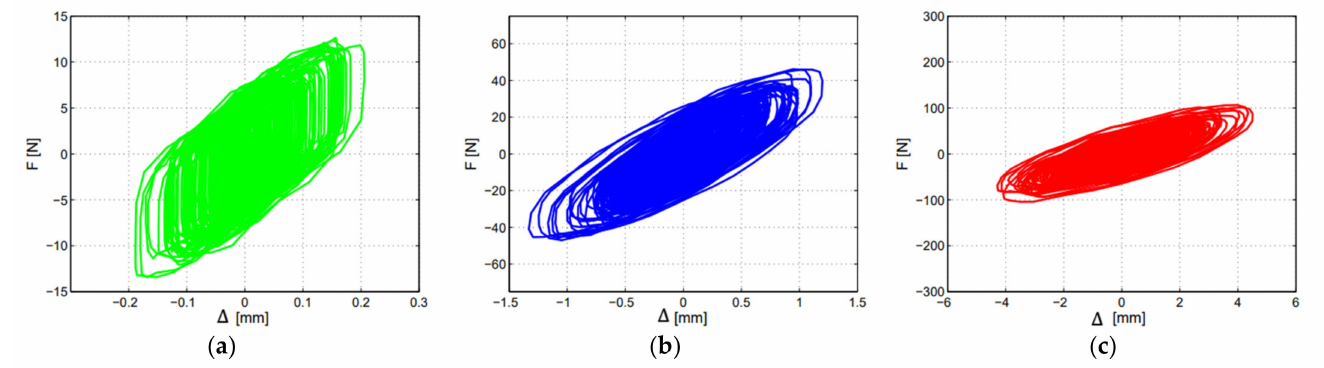
Figure 9. WN. FTMD configuration, force displacement cycles of the isolators: ( a ) WN01 = 0.002 g, ( b ) WN05 = 0.008 g, ( c ) WN12 = 0.025